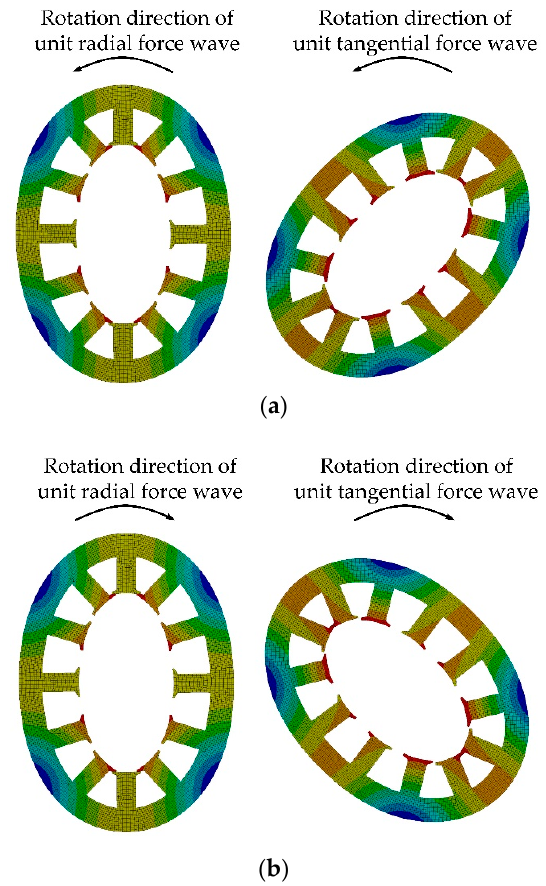
Figure 2. Stator vibration deformation produced by unit radial and tangential force waves, respec- tively. ( a ) Counterclockwise rotation; ( b ) clockwise rotation.